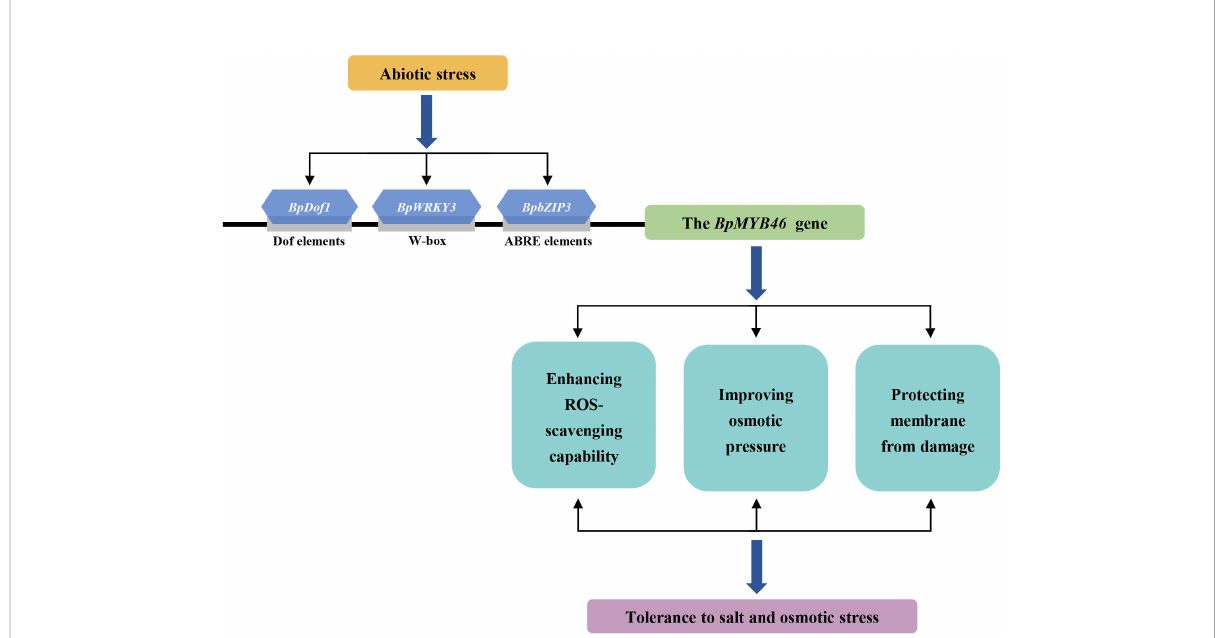
FIGURE 13 Model of the upstream regulatory network of BplMYB46 involved in abiotic stress responses. Abiotic stress, such as salt or osmotic stress, signi fi cantly induce the expression of BpDof1 , BpWRKY3 , and BpdZIP3 . The activated BpDof1, BpWRKY3, and BpdZIP3 then separately binds to Dof, W-box and ABRE elements to regulate the expression of BplMYB46 gene, which result in signi fi cant physiological changes, including reduced reactive oxygen species (ROS) accumulation and membrane damage, and improved osmotic pressure, leading to enhanced salt and osmotic stress